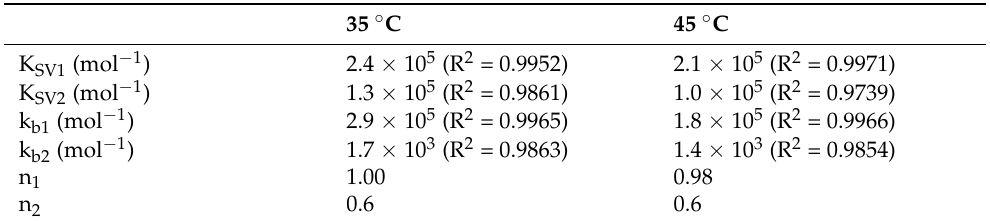
Table 2. Stern–Volmer quenching constants (Ksv1, Ksv2), biomolecular quenching constants (kb1, kb2), and binding constants (n1, n2) obtained from the corrected fluorescence data of HSA– indomethacin interaction at 35 ◦ C and 45 ◦ C by exciting the protein at 295